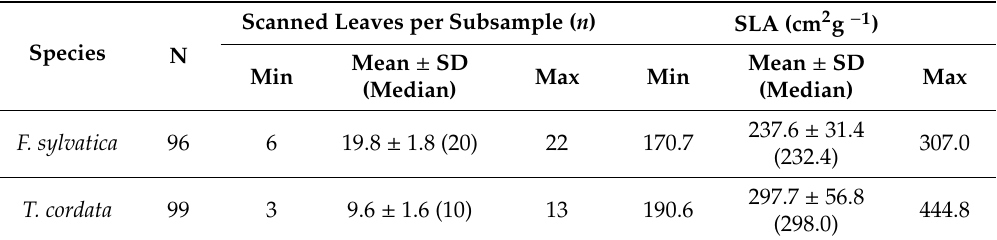
Table 4. Number of scanned leaves and determined specific leaf area per subsample. Number of scanned leaves and SLA in F. sylvatica and T. cordata after the vegetation season 2017. Shown are